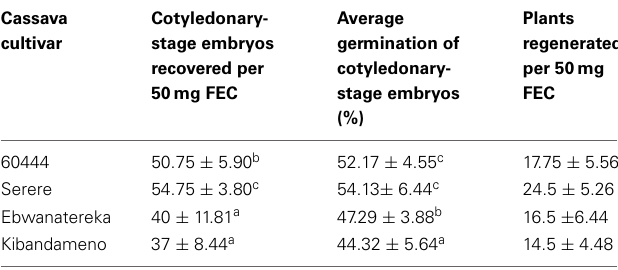
Values are means ± SD of three independent experiments. Values in a column followed by differentlettersaresignificantlydifferent fromeachother atp ≤